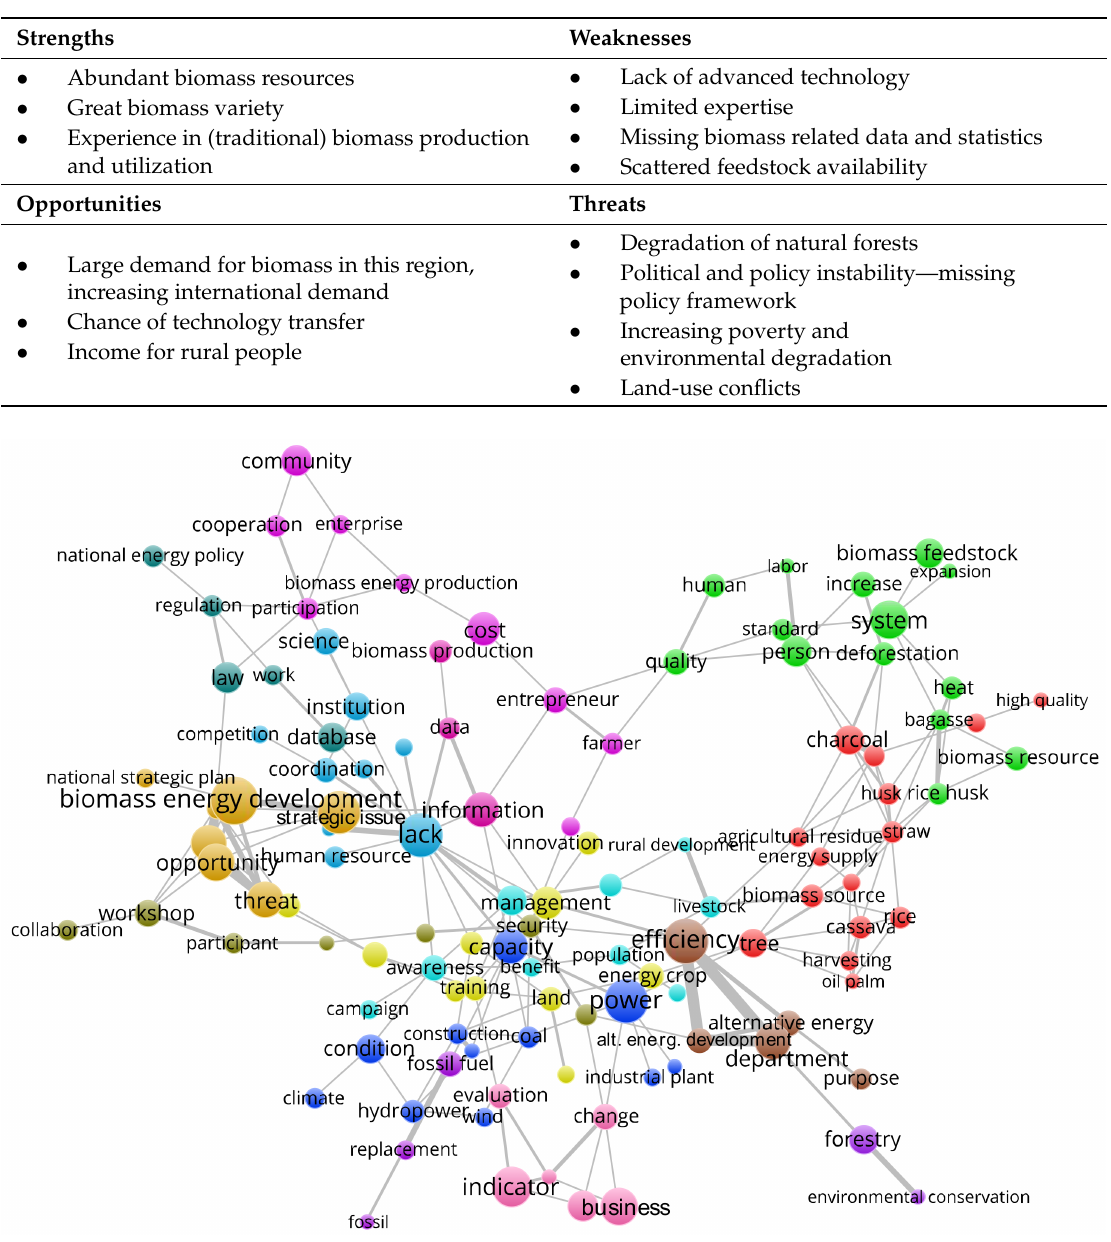
Figure 2. Key items (circles, n = 115) displayed in a term map with 15 clusters (represented by different colors) and 201 links (lines). The size of the circles represents the occurrence and the width of the connecting lines the link strength. The distance between items represents their topical distance in the NBDPs. The cluster color represents a topical focus area. Data source: authors’ compilation